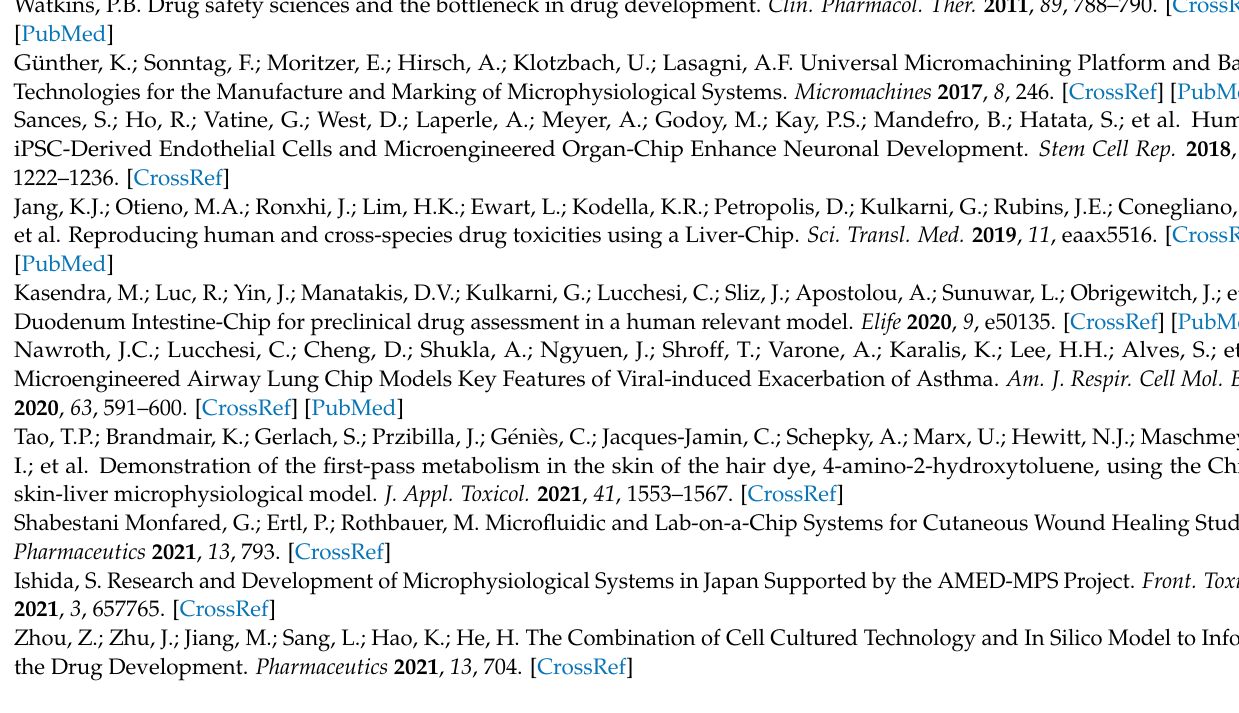
Table S3. Gene list of focused